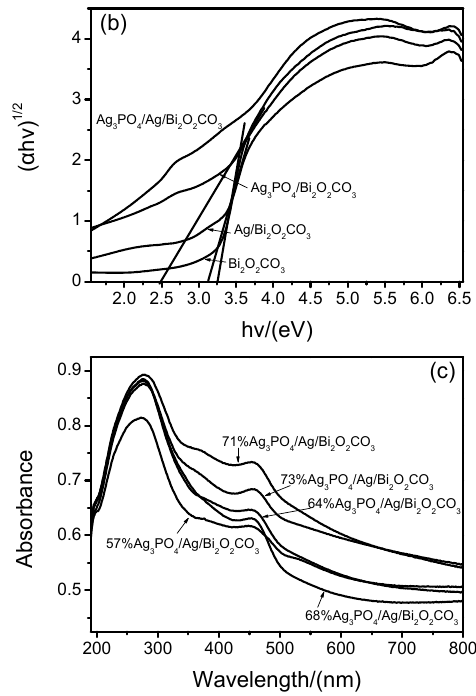
Figure 4. UV ‐ vis diffuse reflectance spectra of the different photo ‐ catalysts. ( a ) UV ‐ vis DRS of the Figure 4. UV-vis diffuse reflectance spectra of the different photo-catalysts. ( a ) UV-vis DRS of the different catalysts ( b ) UV ‐ vis DRS transferring spectra ‐ ( α h ν ) 1/2 ~h ν of the different catalysts ( c ) different catalysts ( b ) UV-vis DRS transferring spectra-( α h ν ) 1/2 ~h ν of the different catalysts ( c ) UV-vis UV ‐ vis DRS of the different amounts of Ag 3 PO 4 /Ag/Bi 2 O 2 CO 3 catalysts. DRS of the different amounts of Ag 3 PO 4 /Ag/Bi 2 O 2 CO 3